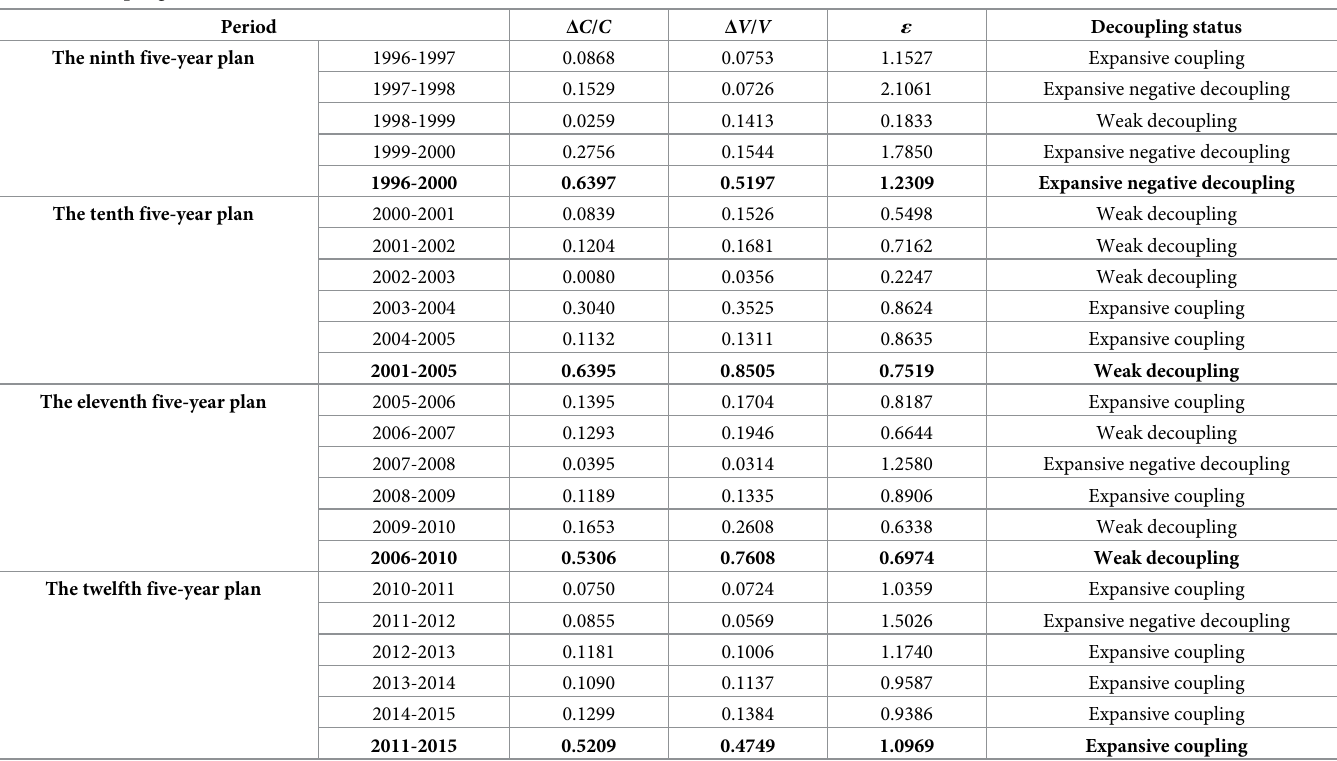
Table 4. Decoupling status of carbon emissions in the civil aviation, 1996-2015.